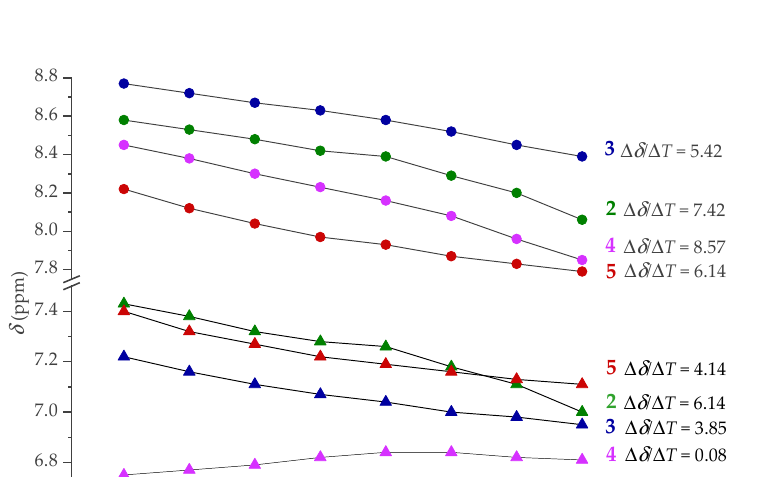
5 Figure 7. Concentration-dependent NH chemical shifts of hetero-( 2 , 3 ) and homochiral peptides ( 4 , 5 ). Next, concentration-, temperature- and solvent-dependent NMR spectroscopy was performed to obtain further details about the conformational space of the tested conju- gates. NH Fn and NH Ala showed no significant upfield shifts ( δ < 0.1 ppm) at high (50 mM) vs. low concentrations (1 mM) (Figure 7), supporting their involvement in IHBs, as sug- gested by the concentration-independent IR data (Figure 6a,b). We have further estimated the stability of the intramolecularly hydrogen-bonded structures in peptides 2 – 5 by examining the temperature dependence of the shifts of the